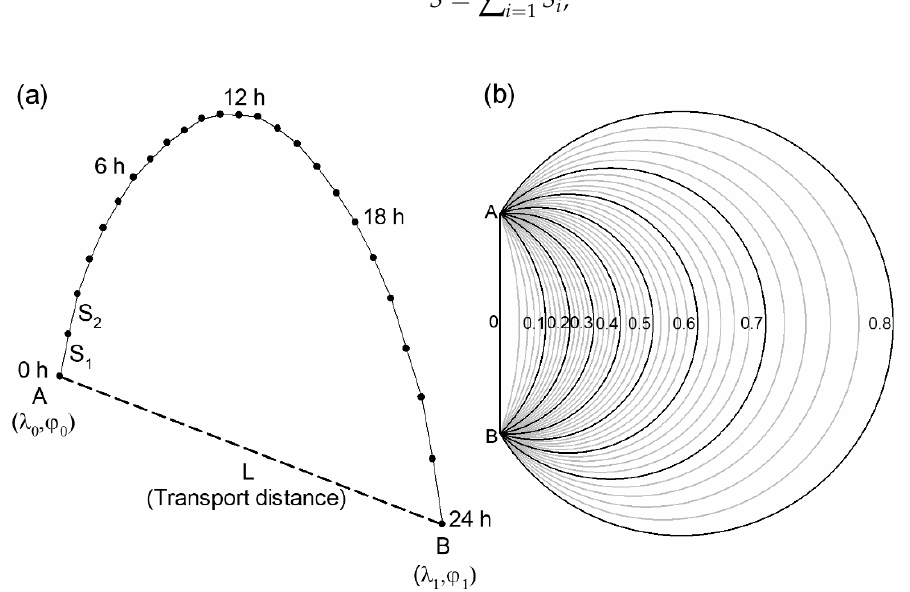
Figure 1. ( a ) An example of one-day backward trajectory from B to A, together with the transport distance L. The wind run is the addition of distances S i. ( b ) Recirculation factors when the trajectories from B to A are circumference arcs. In this figure, AB is the transport distance. The lowest value of the recirculation factor corresponds to the run from A to B following a straight line. When the arc increases, so does the recirculation factor.